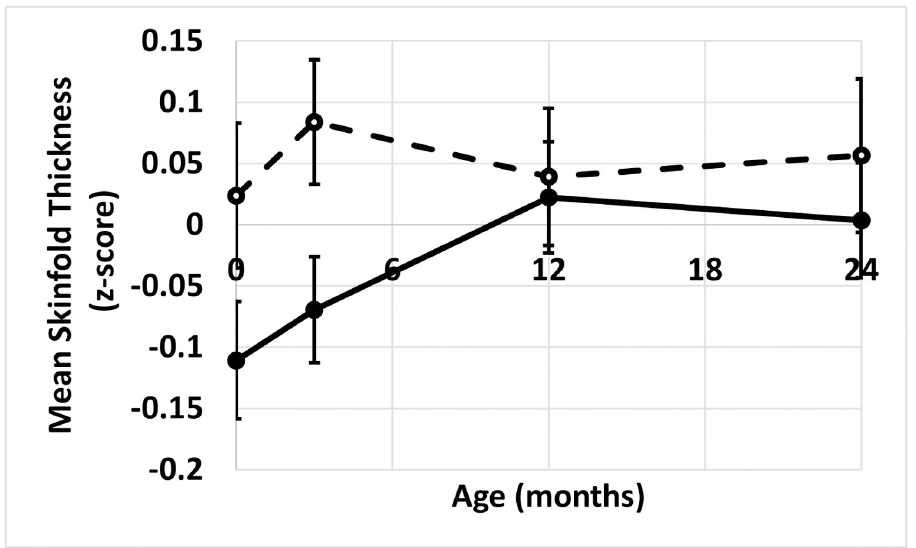
Fig 2. The change in mean skinfold thickness z-score over the first two years of life. The dotted line represents data from children (n = 272) whose mothers supplemented with iron during pregnancy. The solid line represents data from children (n = 178) whose mothers did not report supplementing with iron during pregnancy. Data are mean (SEM).